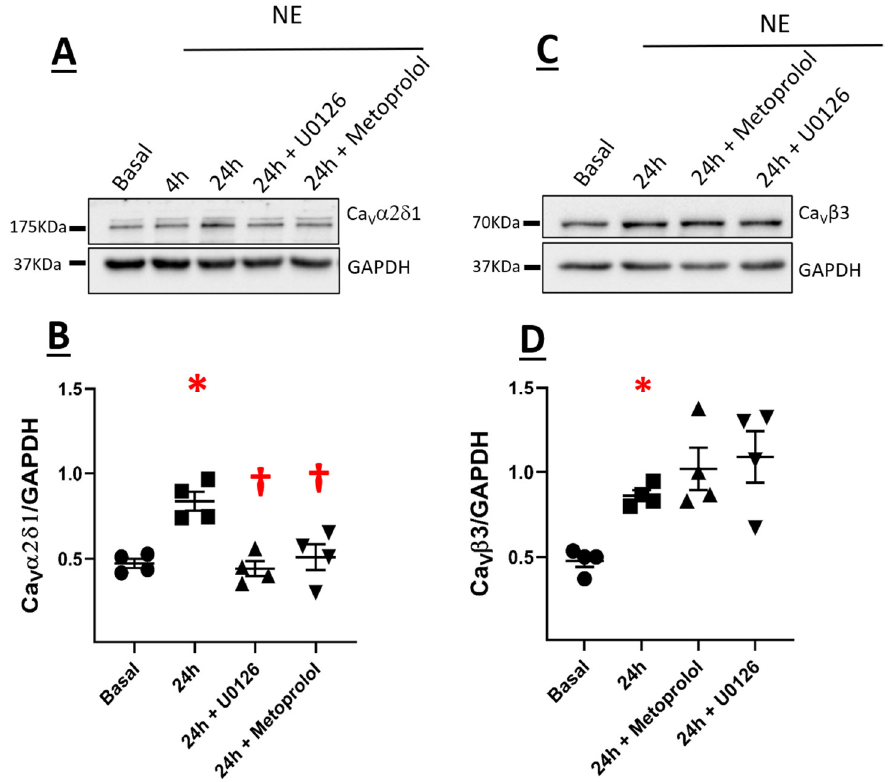
Figure 7. Expression of Ca V α2δ1 ( A ) and Ca V β3 ( C ) in neonatal rat cardiomyocytes. Total proteins were extracted from neonatal rat ventricular cardiomyocytes. Cells were treated with 1 μM Norepi- nephrine (NE) for 24 h or pre-treated with metoprolol tartrate (β1-blocker) for 1 h followed by treatment with NE for 24 h. Proteins were separated on an 8% SDS-polyacrylamide gel, transferred to a nitrocellulose membrane, and probed with anti-Ca V α 2 δ 1, anti-Ca V β 3, and anti-GAPDH antibodies overnight and then incubated with HRP-conjugated goat anti-rabbit secondary antibody. Lanes were loaded with 30 μg of proteins. NE: cardiomyocytes treated with 1 μM norepinephrine. 24 h + metoprolol tartrate: Cardiomyocytes pre-treated with metoprolol tartrate (β1-blocker) for 1 h, followed by treatment with NE for 24 h. ( B ) Graph showing the total protein expression of Ca V α2δ1 normalized to GAPDH. * p < 0.01 vs. Basal untreated NRVMs; † p <0.01 vs. NE 24 h. (4 cardio-prep- arations). ( D ) Graph showing the total protein expression of Ca V β3 normalized to GAPDH. * p < 0.01 vs. Basal untreated NRVMs (4 cardio-preparations). Statistical analysis was performed using one- way ANOVA.